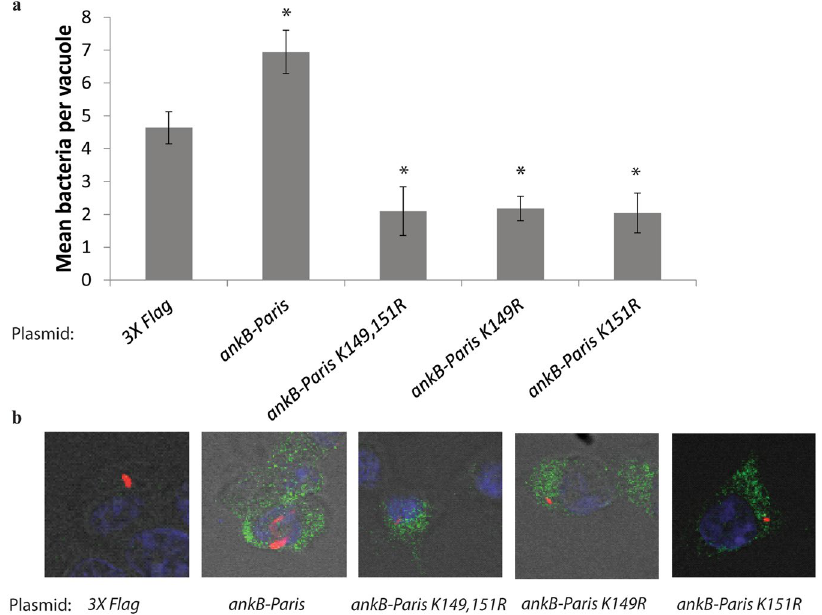
Figure 8. Requirement of the putative di-lysine motif in the C-terminus of ectopically expressed AnkB-Paris for trans -rescue of the ankB mutant. ( a ) HEK293T cells were first transfected with plasmids encoding 3X-Flag empty vector, 3X-Flag AnkB-Paris, 3X-Flag AnkB-Paris K 149,151 R, 3X-Flag AnkB-Paris K 149 R, or 3X-Flag AnkB- Paris K 151 R and then infected with the ankB mutant. Intracellular replication was analyzed at 10 hours post infection by confocal microscopy. The results are based on examination of 50 infected/transfected cells using three biological replicates. The mean number of bacteria per transfected HEK293T cell is shown. Error bars represent 1 standard deviation. * p < 0.01 compared to cells transfected with empty vector. ( b ) Representative confocal microscopy images of cells infected with the ankB mutant and expressing the indicated 3X Flag-ankB fusion. Anti-flag staining is shown in green and anti-Lpn is shown in